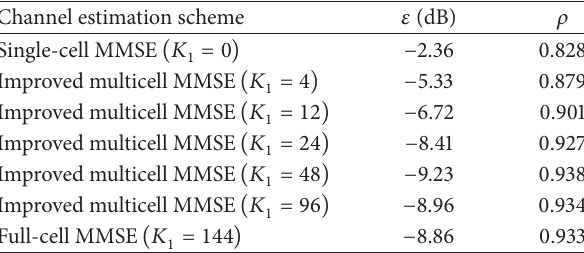
Table 3: Performance comparison of channel estimation